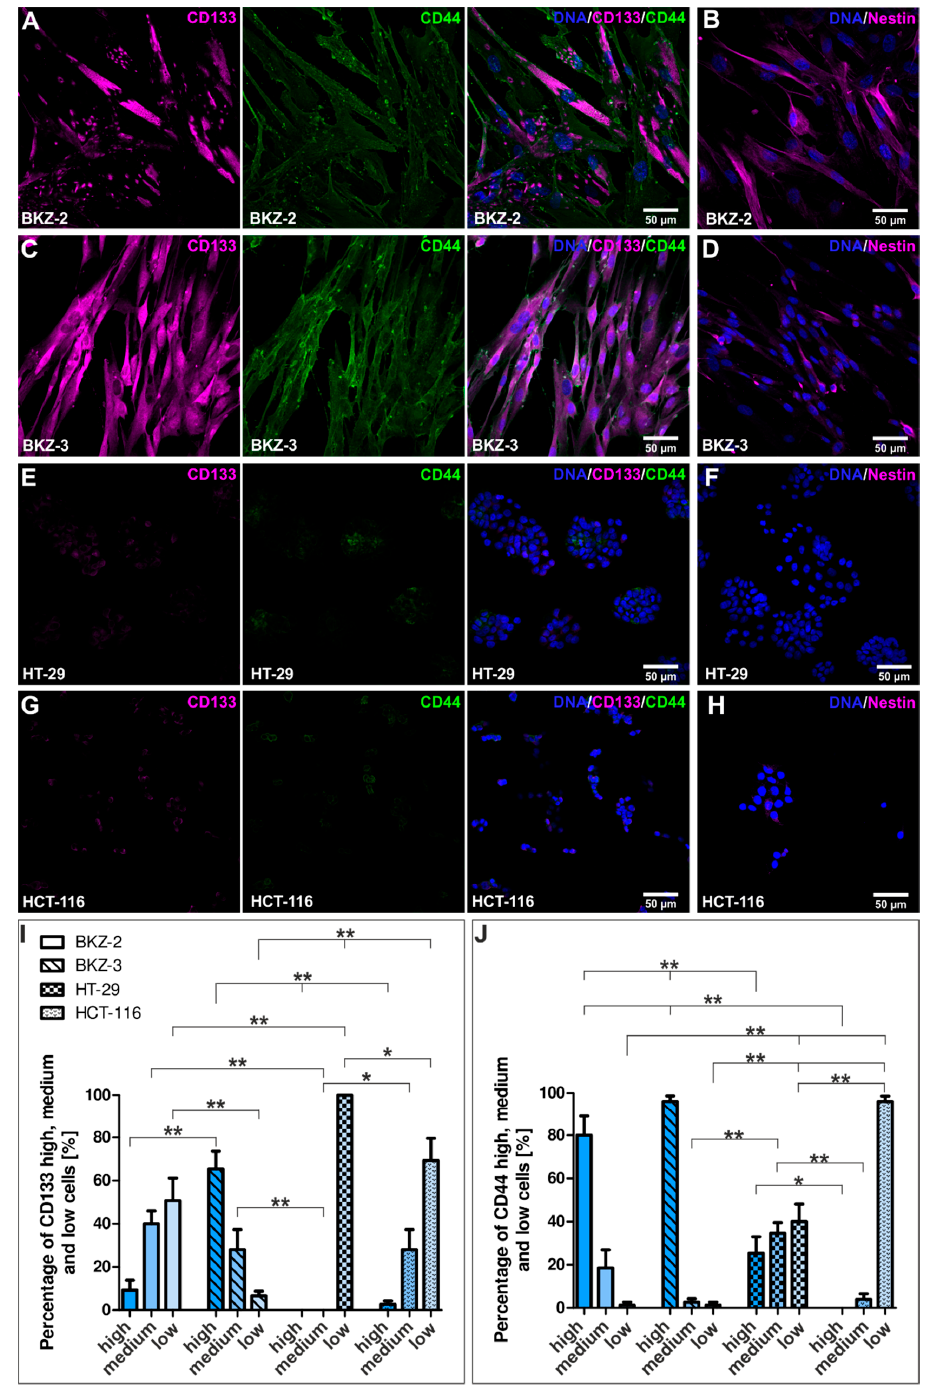
Figure 5. BKZ-2 and BKZ-3 express higher amounts of prominin-1 (CD133) and CD44 antigen (CD44) in comparison to HT-29 and HCT-116. Immunocytochemical analysis of BKZ-2 and BKZ-3 displayed high positivity for the cancer stem cell (CSC)-markers ( A/C ) CD133, CD44 and ( B/D ) Nestin, validating the isolation of two new cell lines that contain a subpopulation of cells with potential stem-like properties. Immunocytochemical analysis of the common colon carcinoma cell lines HT-29 and HCT-116 only displayed slight expression of the CSC-markers ( E/G ) CD133, CD44 and ( F/H ) Nestin. Quantification of the percentage of ( I ) CD133 high, medium and low cells revealed a significantly elevated amount of CD133 high BKZ-3 cells in comparison to BKZ-2, HT-29 and HCT-116. Moreover, the percentage of HT-29 and HCT-116 CD133 low cells was significantly higher when compared to BKZ-2 and